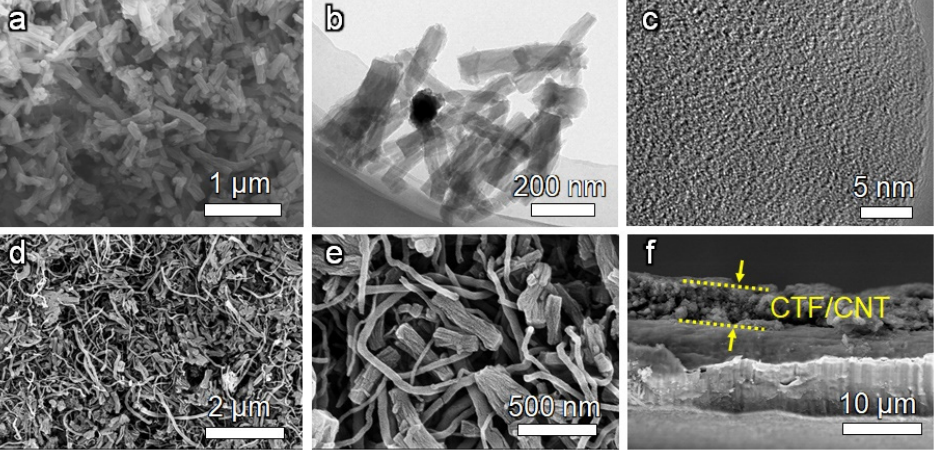
Figure 3. ( a ) SEM image, ( b ) TEM image, and ( c ) HRTEM image of the CTF. ( d,e ) Top-view SEM images and ( f ) cross-sectional SEM image of the CTF/CNT/Celgard separator.